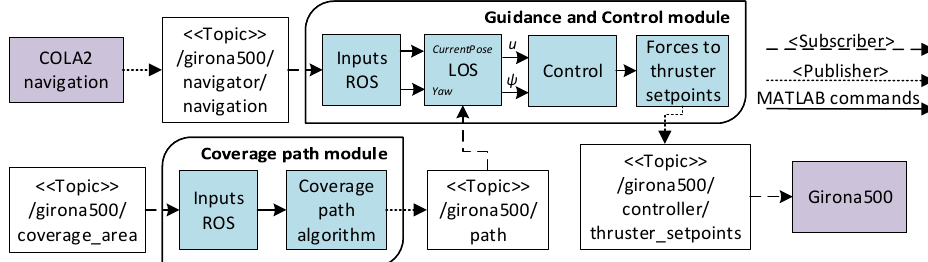
Figure 9. Modular GNC architecture schematic. The two GNC modules (guidance and control and coverage path modules) run independent ROS